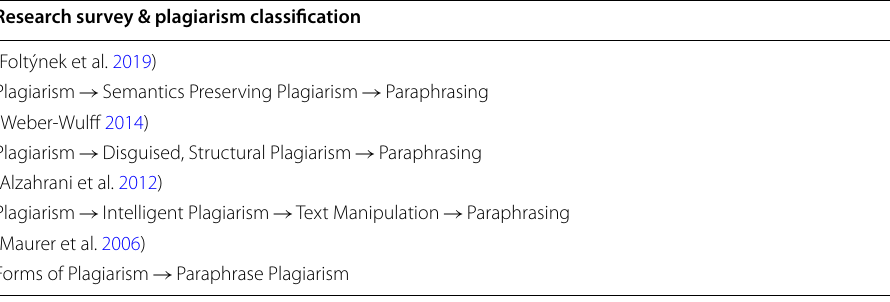
Table 1 Classification indicating paraphrase plagiarism in various research surveys Research survey & plagiarism